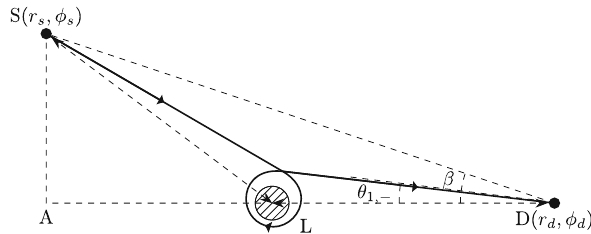
Fig. 1 The GL in the SFL. ( r d ,φ d ) and ( r s ,φ s ) are respectively the radialandangularcoordinatesofthedetectorDandsourceS.Thesignal winds clockwiselyone loop around the lens L. b is theimpact parameter and the shadow stands for the